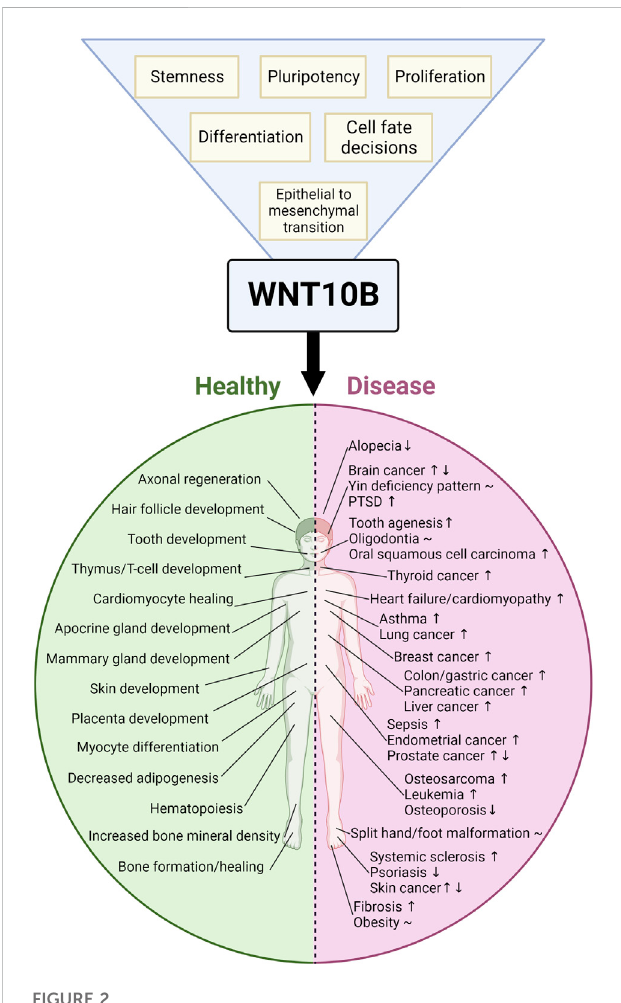
FIGURE 2 Summarizing the role of WNT10B in physiology and disease. The blue triangle with yellow squares represents across-tissue phenotypic observations of WNT10B ’ s function in physiology and disease, whereas the pink/green circle represents the tissue-speci fi c roles of WNT10B.The greensiderepresentstissues that areaffectedbyWNT10B in a healthy developmental model, whereas the pink side represents the role of WNT10B in diseases. To the right of the disease is a symbol representing overexpression ( ↑ ),decreasedexpression( ↓ ),orboth ( ↑↓ )of WNT10B. Additionally, diseases characterized by polymorphisms or mutations in WNT10B are given a (~) symbol. Created with